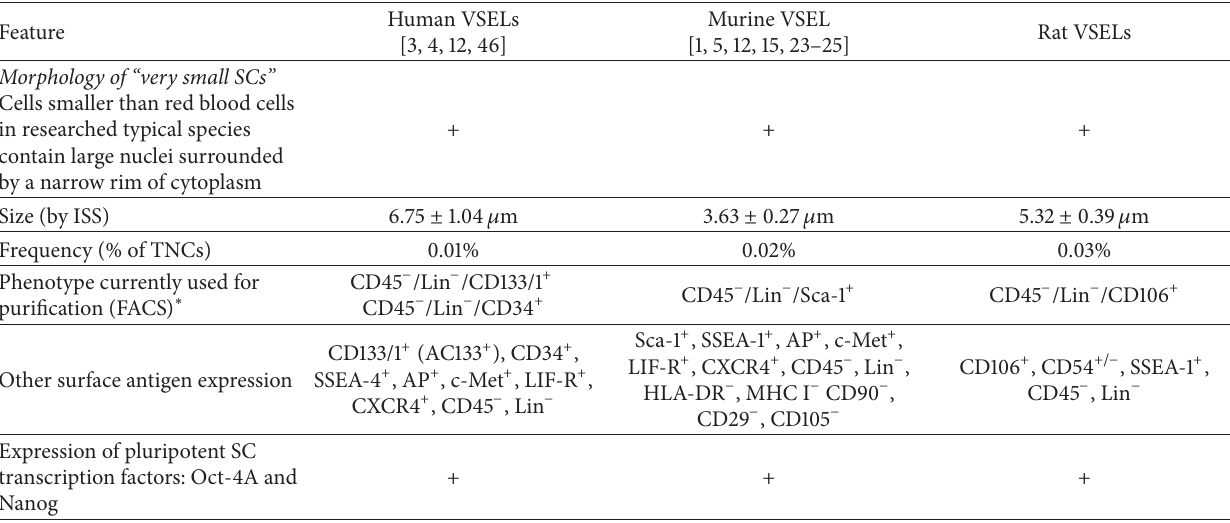
Table 3: Comparison of major features and phenotype of human and murine VSELs with rat BM-derived